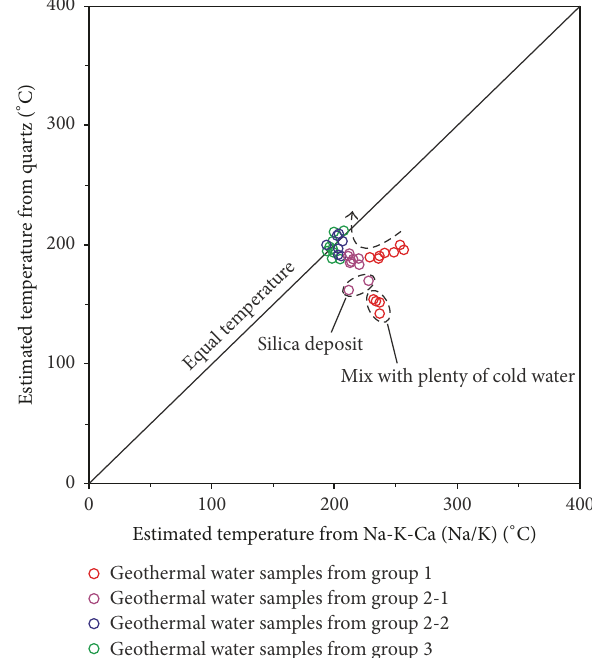
Figure 8: Comparison of geothermal reservoir temperatures esti- mated using quartz and Na/K (Na-K-Ca) geothermometers in the research area. Na/K results were applied to samples of group 1, and Na-K-Ca results were applied to samples of groups 2 and